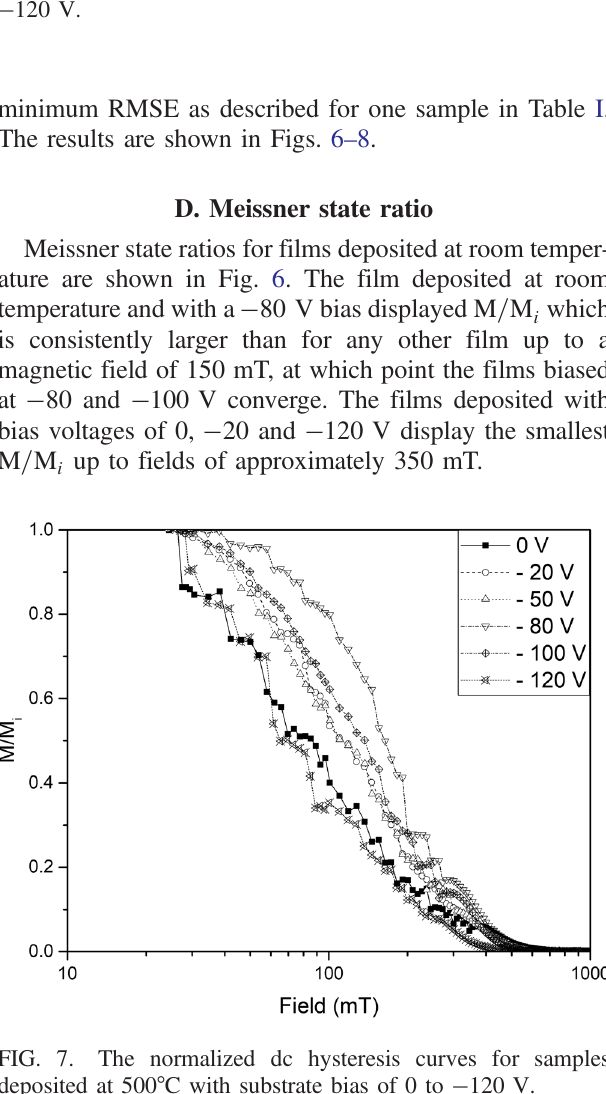
FIG. 6. The normalized dc hysteresis curves for samples deposited at room temperature with substrate bias of 0 to − 120 V.